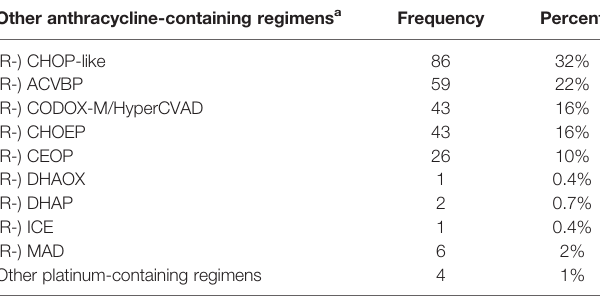
TABLE 2 | Breakdown of other anthracycline-containing fi rst-line regimens. Other anthracycline-containing regimens